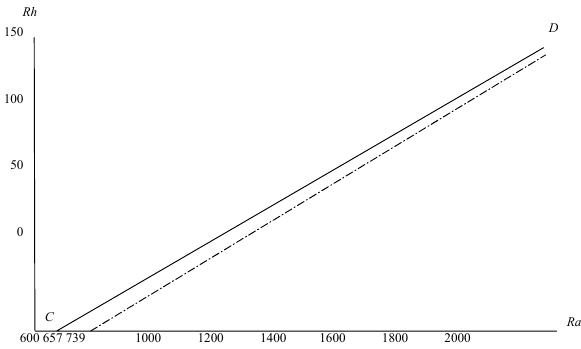
Fig. 2. Locus of the point A in the ( R a ,R h ) plane when τ varies from 0 to + ∞ . The numerical values are the same as in Fig. 1. The way followed by A when τ varies (continuous curve) is almost rectilinear. This curve goes very slowly to its asymptote (dotted straight